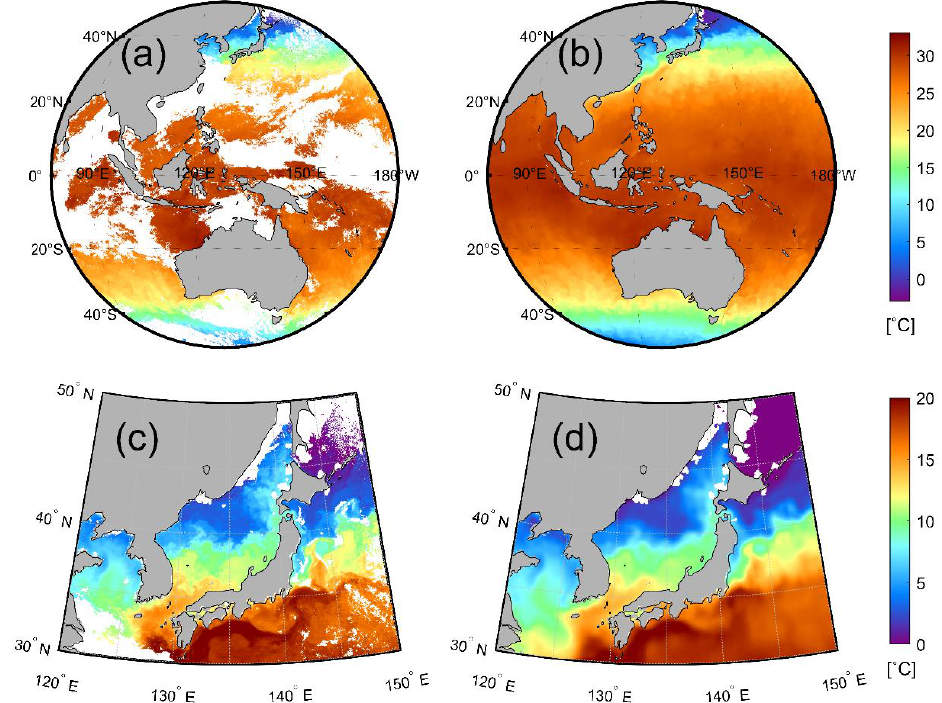
Figure 13. Example of daily SST fields ( ◦ C) from ( a ) COMS/MI-derived SST and ( b ) OSTIA on March 26, 2015. ( c , d ) are SSTs in the seas around the Korean Peninsula, enlarged images from ( a , b ), respectively. The OSTIA SST is one of the best SST composites; it combines all available satellite data and in situ measurements over the course of a day. However, its current product does not include any SSTs from geostationary satellite data covering this particular region. Thus, it is believed that the SST product may depend on AMSR2 SSTs from microwave remote sensing in the optimal interpolation